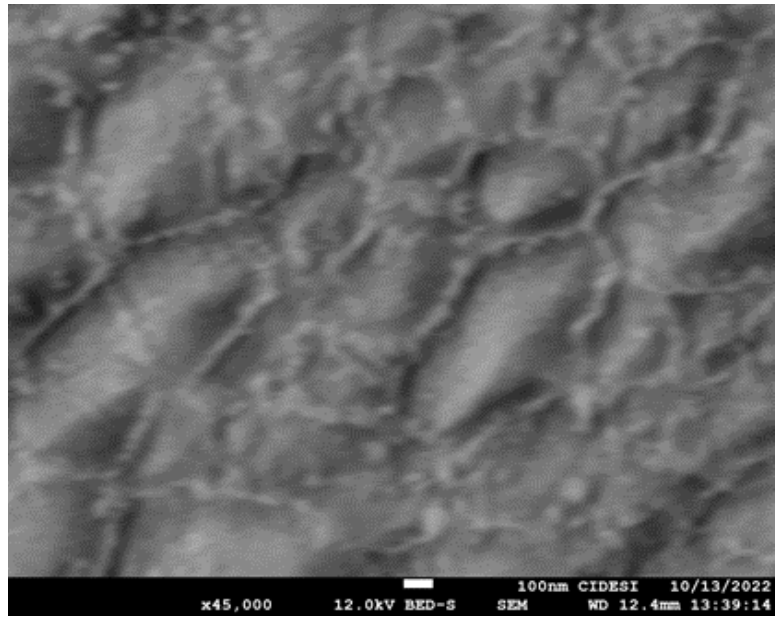
Figure 7. Microstructure at 45,000× of cellular IN718 after 10 h of aging using backscattered electrons. The subgrain structures can be observed.